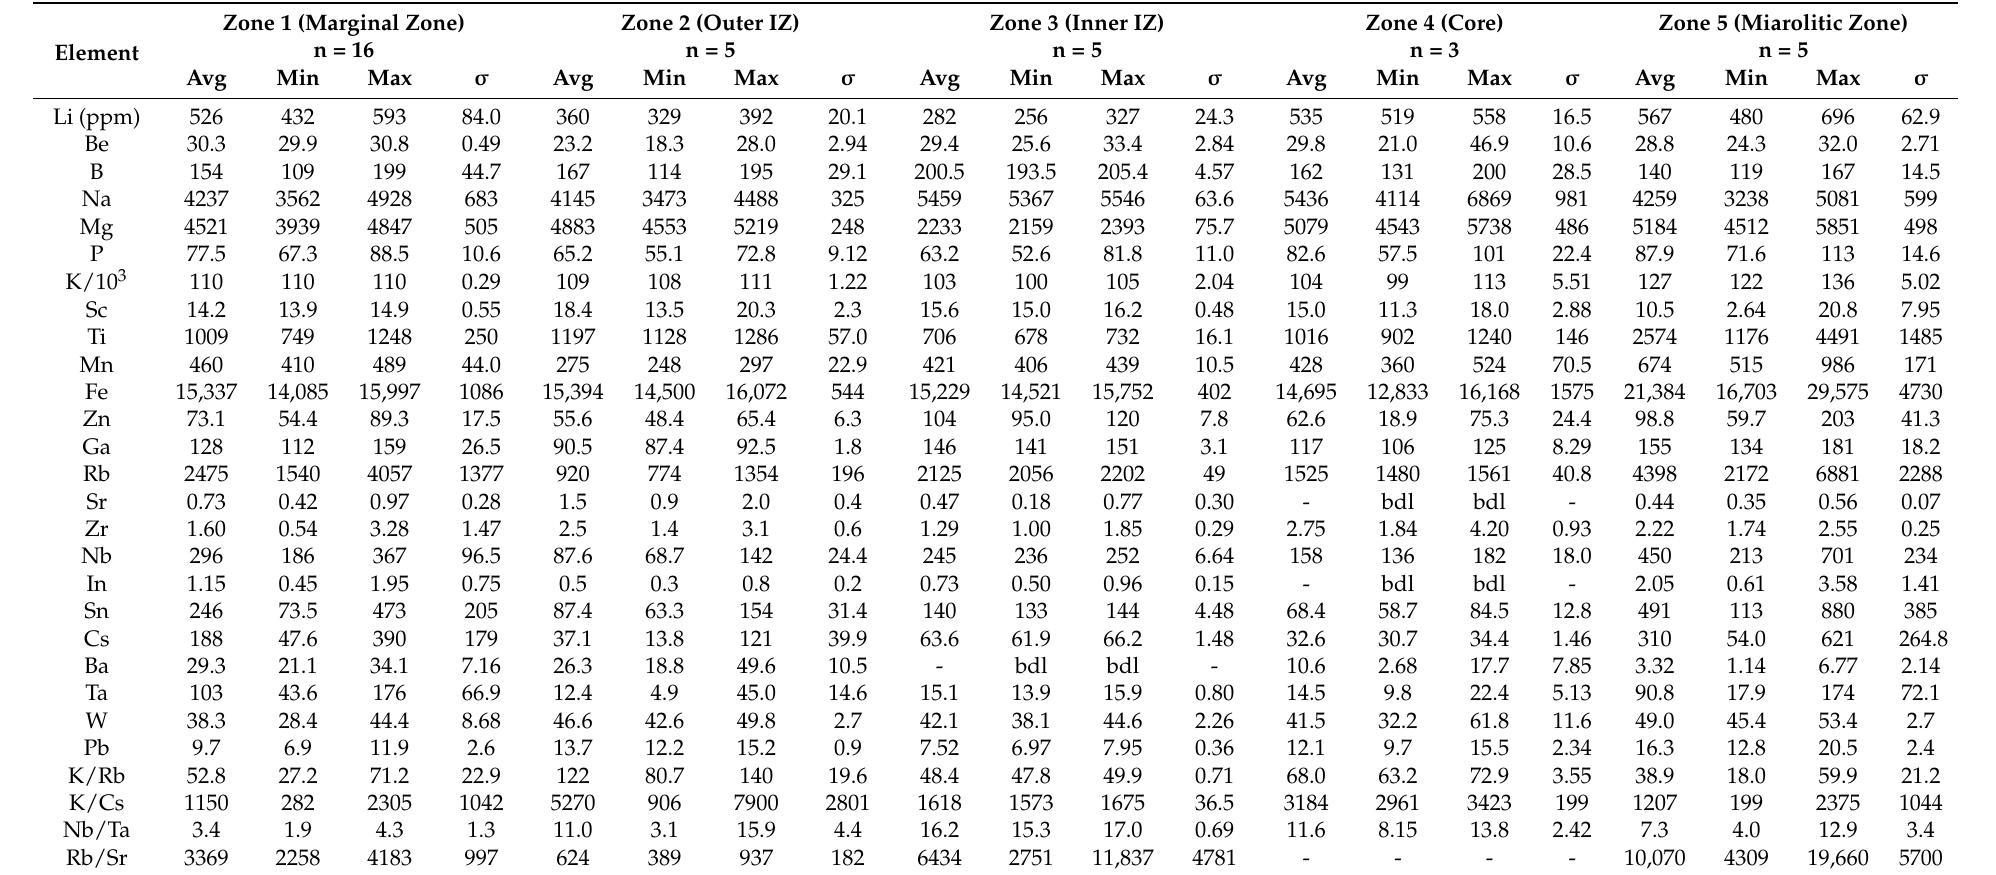
Table 6. The average LA-ICP-MS trace element composition of muscovite from the Yamrang Pegmatite, Ikhabu Pegmatite Field (IPF), Eastern